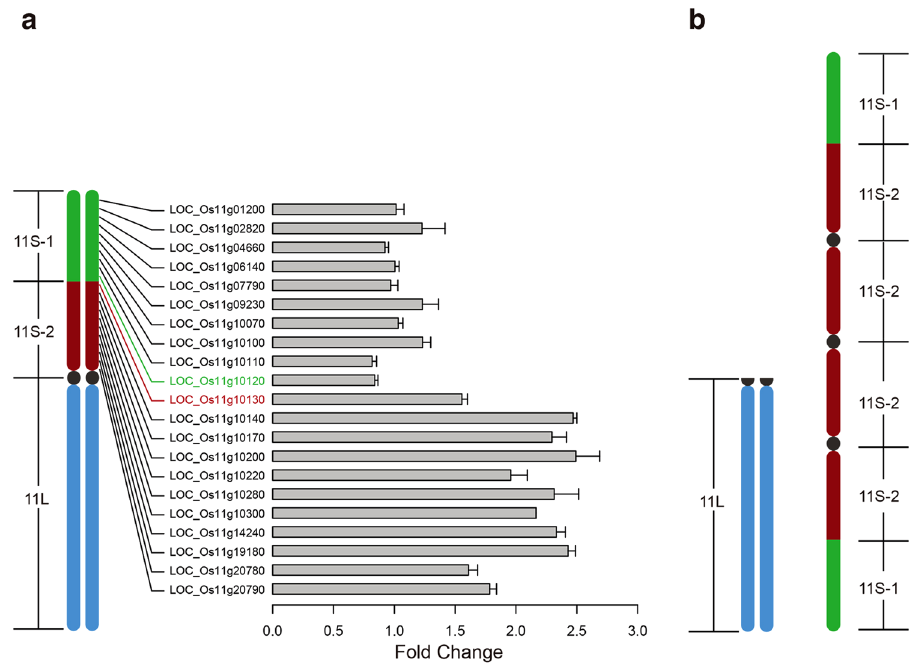
Figure 3. Real-time quantitative PCR analysis and model of Chr11 in YZG-5. ( a ) Diagram of Chr11 with 21 related genes uniformly distributed on the short arm and qPCR results. The level of gene expression differed almost two-fold between Os11g01200-11g10130 and Os11g10120-11g20790. ( b ) Model pattern of the composition of Chr11 in variant